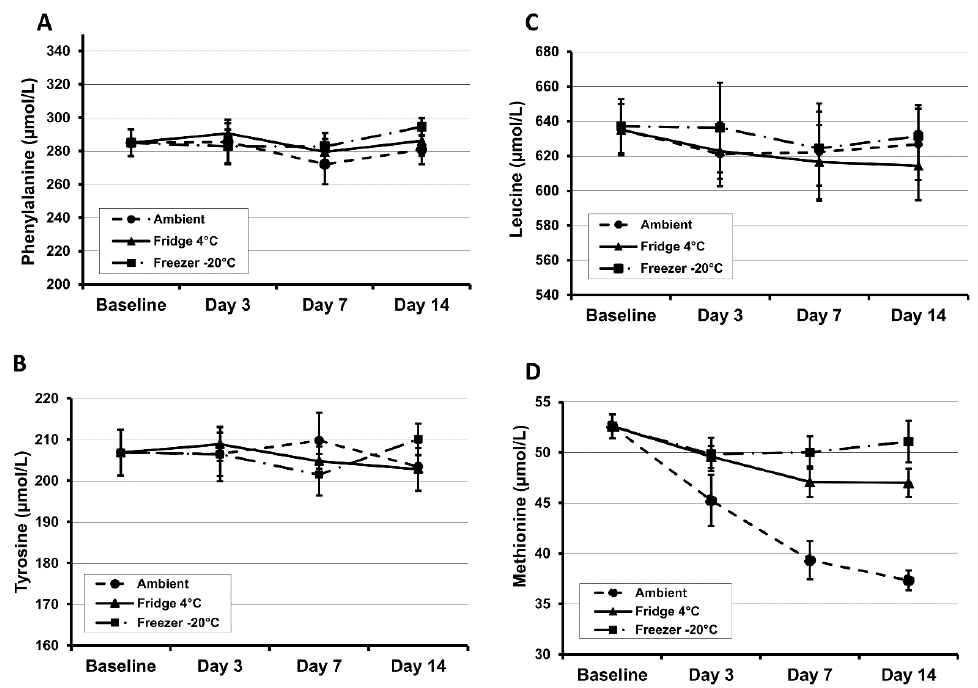
Figure 1. Concentration changes of phenylalanine ( A ), tyrosine ( B ), leucine ( C ) and methionine ( D ) over time in DBS samples (PerkinElmer 226 cards) at various storage temperatures. Results are shown as the mean ± SD; n = 12 replicates in each experiment.